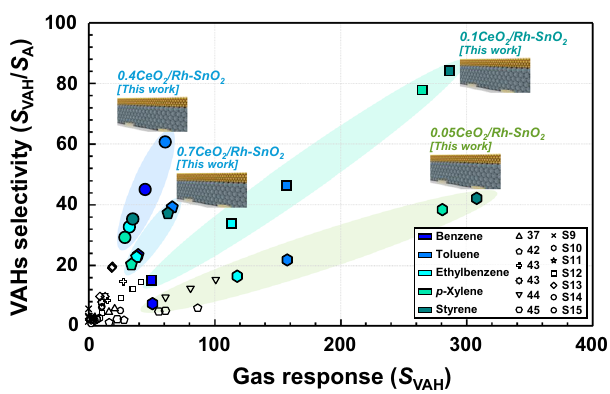
Fig. 5 | Gas-sensing performance ofCeO 2 /Rh – SnO 2 bilayer sensors. Selectivities ( S VAH / S ethanol ) and responses ( S B , S T , S E , S X , and S S ) to VAHs measured in this study compared to those previouslyreported in the literature 37,42 – 45,S9 – S23 . Source dataare provided as a Source Data fi le.